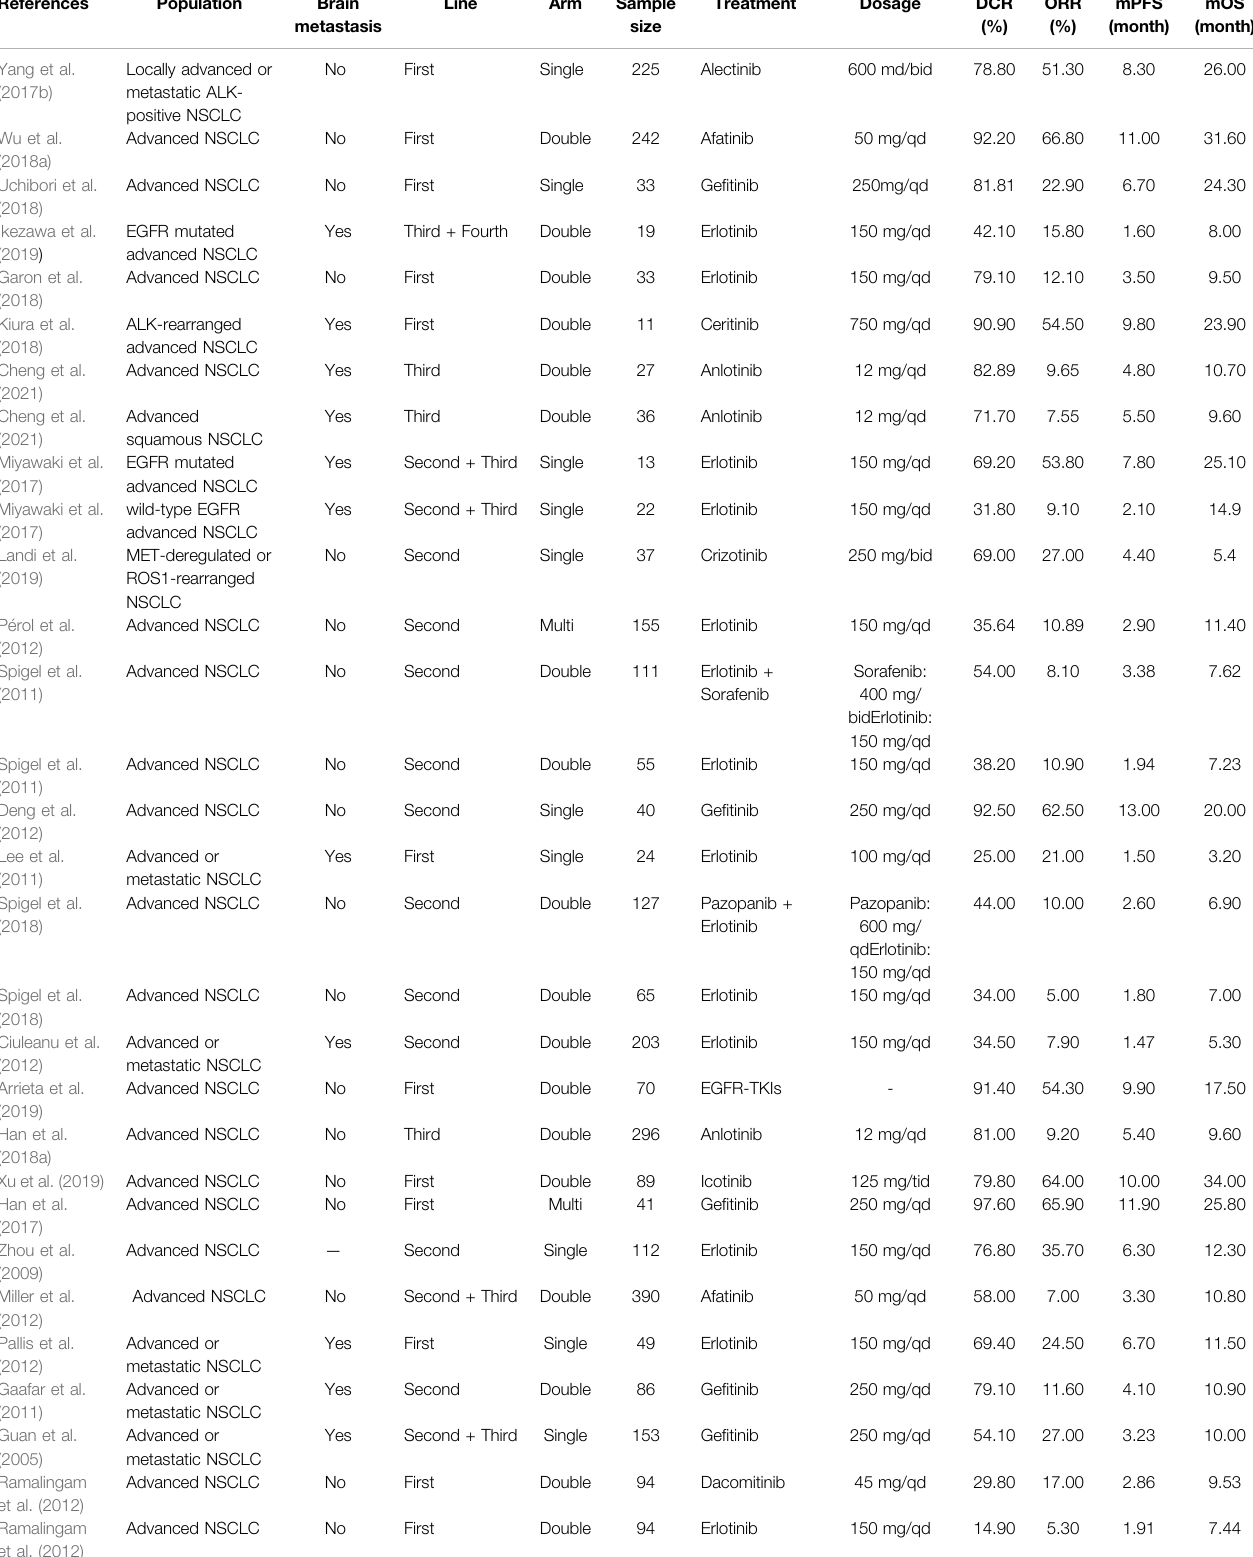
TABLE 3 | Overview of general characteristics of studies reporting ORR, DCR, mPFS, and